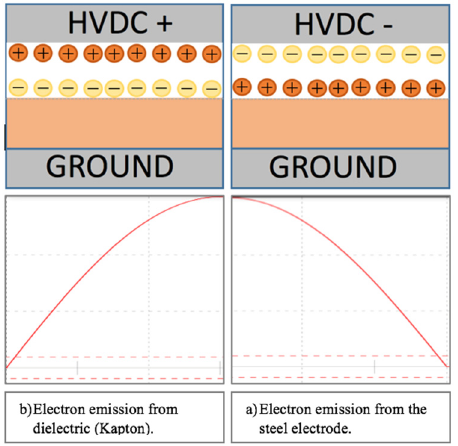
Figure 14. Specimen representation and charge distribution inside the cavity before positive ( a ) and negative ( b ) discharges. negative ( b )